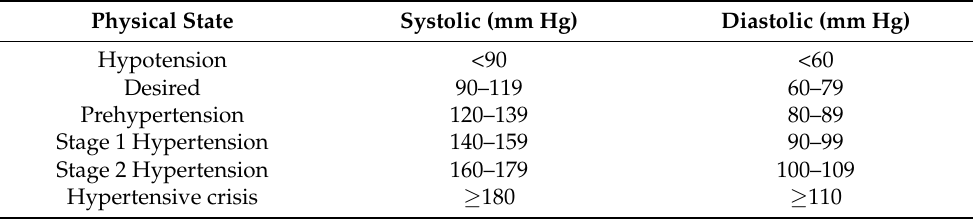
Figure 7. ( a ) Bit map of the RF Modem and ( b ) Bit map of the wrist band. Table 1. Blood pressure categories for ages (18 years and older) [46].